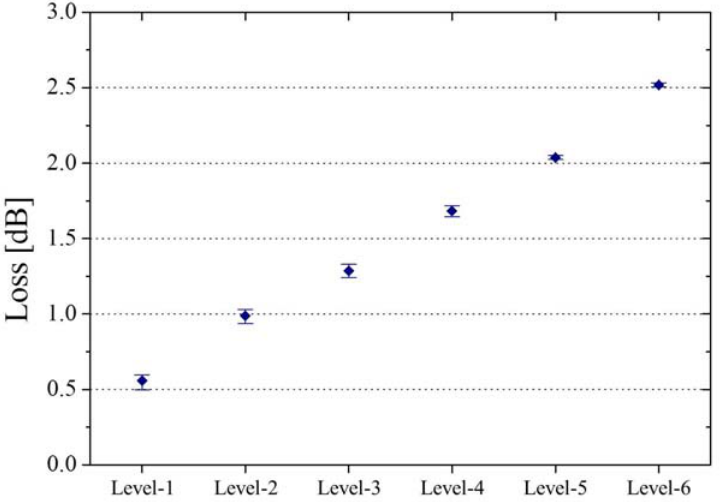
Figure 9. The average of optical loss of each water-level with these five